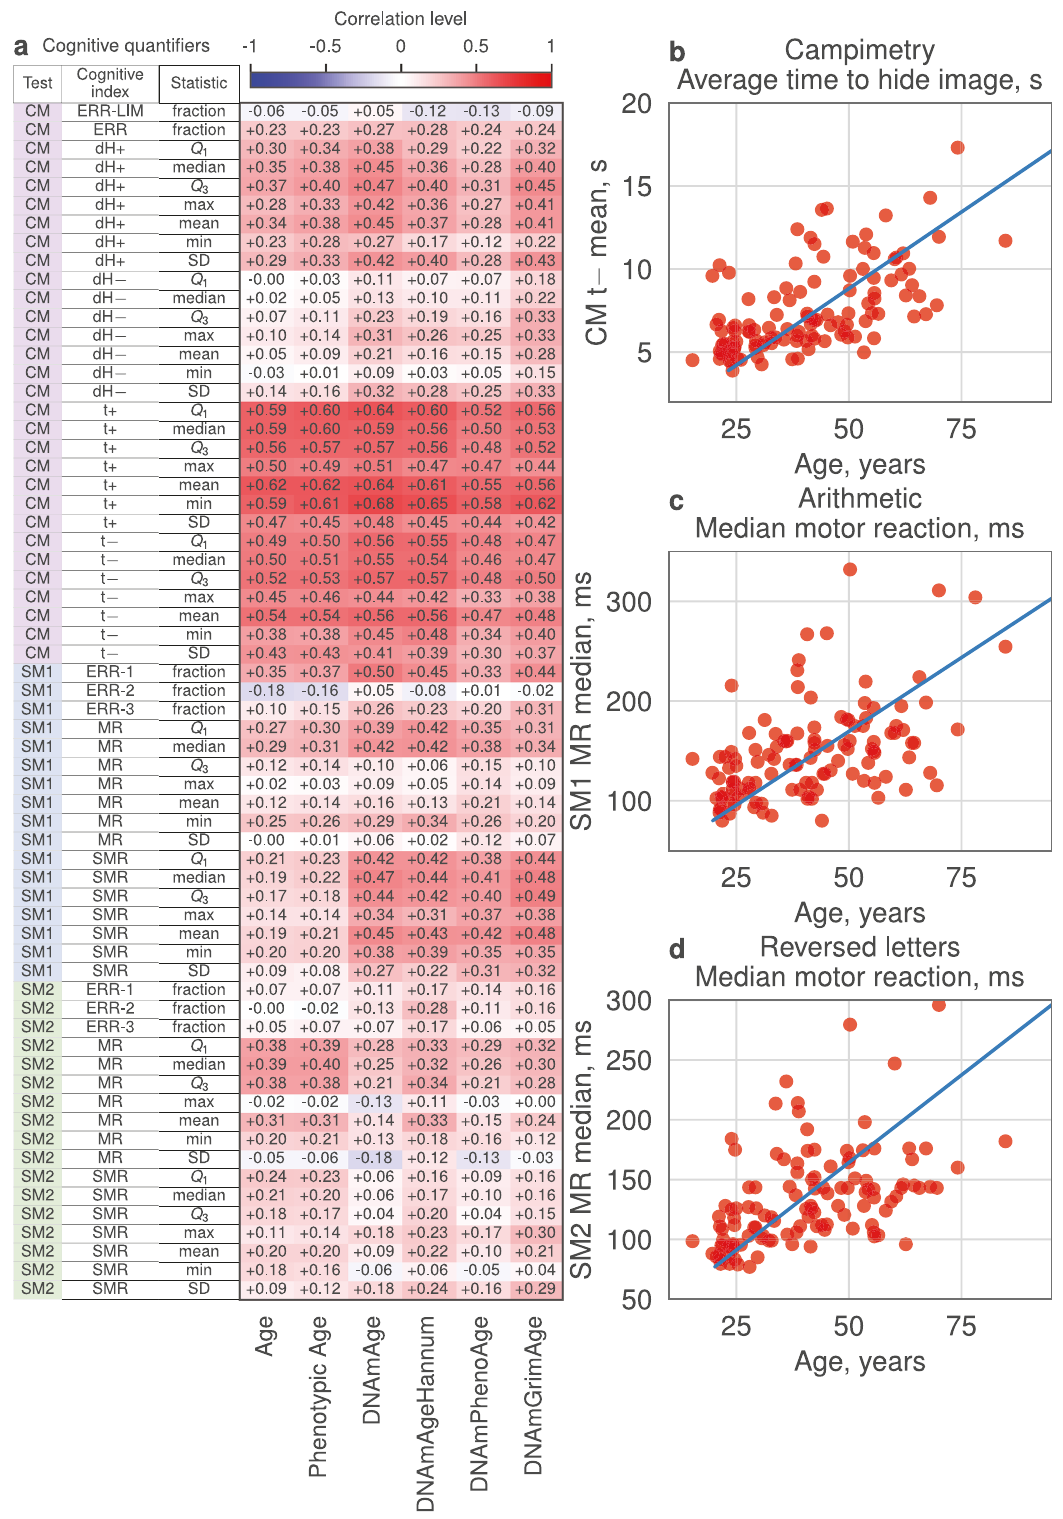
Fig. 2 Association of cognitive quanti fi ers and indices with age. a Pearson correlation coef fi cients resulting from the correlation of cognitive quanti fi ers and each type of age. b – d Examples of cognitive quanti fi ers associated with both clocks and include statistics of six indices: time of stimulus absolute errors in the same order: 5.08 years, 4.01 years, 5.43 years). recognition (CM t + ), time of stimulus hiding (CM t-) and fi rst The prediction of the DNAmAge clock and DNAmAgeHannum clock recognized shade (CM dH + ), and also the fraction of falsely rejected was constructed on the top-ranked 22 quanti fi ers (by correlation correct arithmetic expressions (SM1 ERR-1), the sensorimotor with corresponding epigenetic age). Those quanti fi ers are similar for